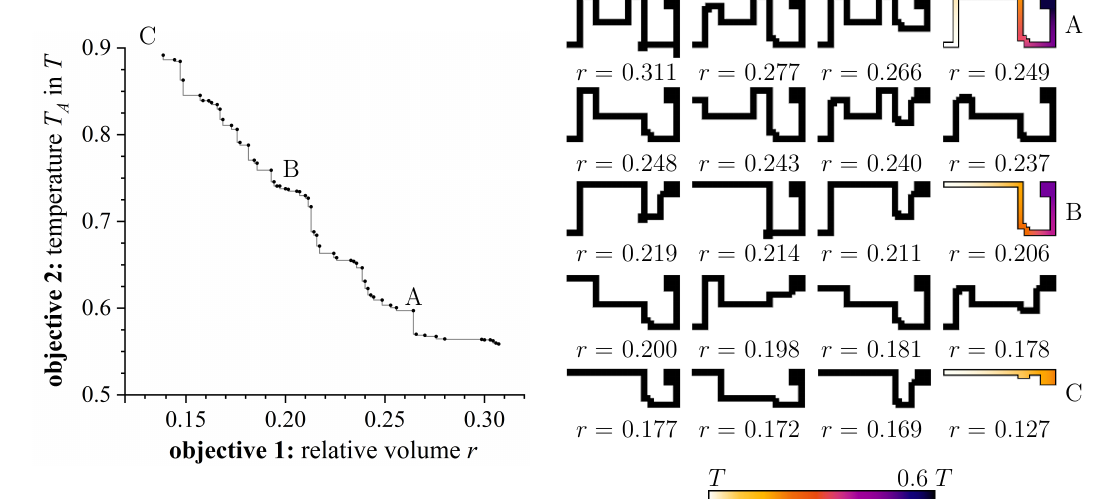
Figure 12. The Pareto front ( left ) and 20 optimized solutions ( right ) to the design problem in Figure 7. Optimization was conducted with respect to the temperature in point A and the relative volume r that is constricted to r ≤ 0.75. For three exemplary structures (A, B, C) the temperature field is given with its respective position in the Pareto